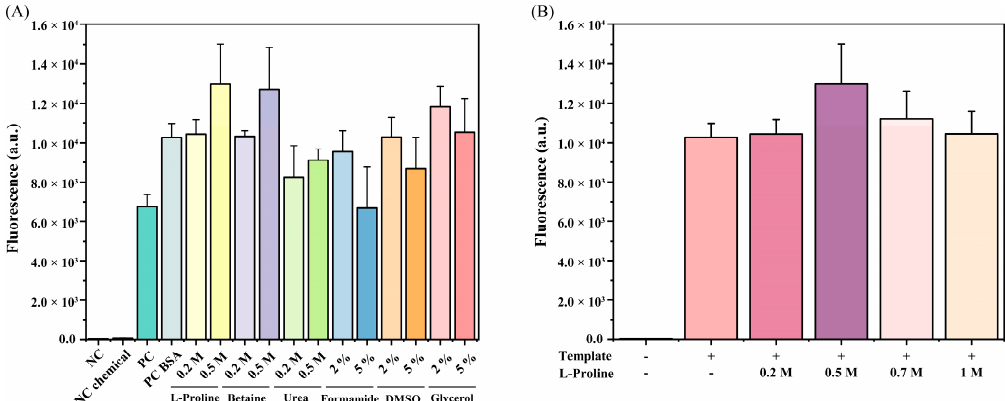
Figure 4. Effects of chemical additives on the CRISPR detection phase. ( A ) Evaluation of the effects of different chemical additives on CRISPR detection systems. NC denotes negative control; NC chemical denotes that no target template was added, but chemical additives were added; PC denotes positive control; PC BSA denotes the addition of target template and BSA. ( B ) The effect of L-proline addition on CRISPR-based detection system.